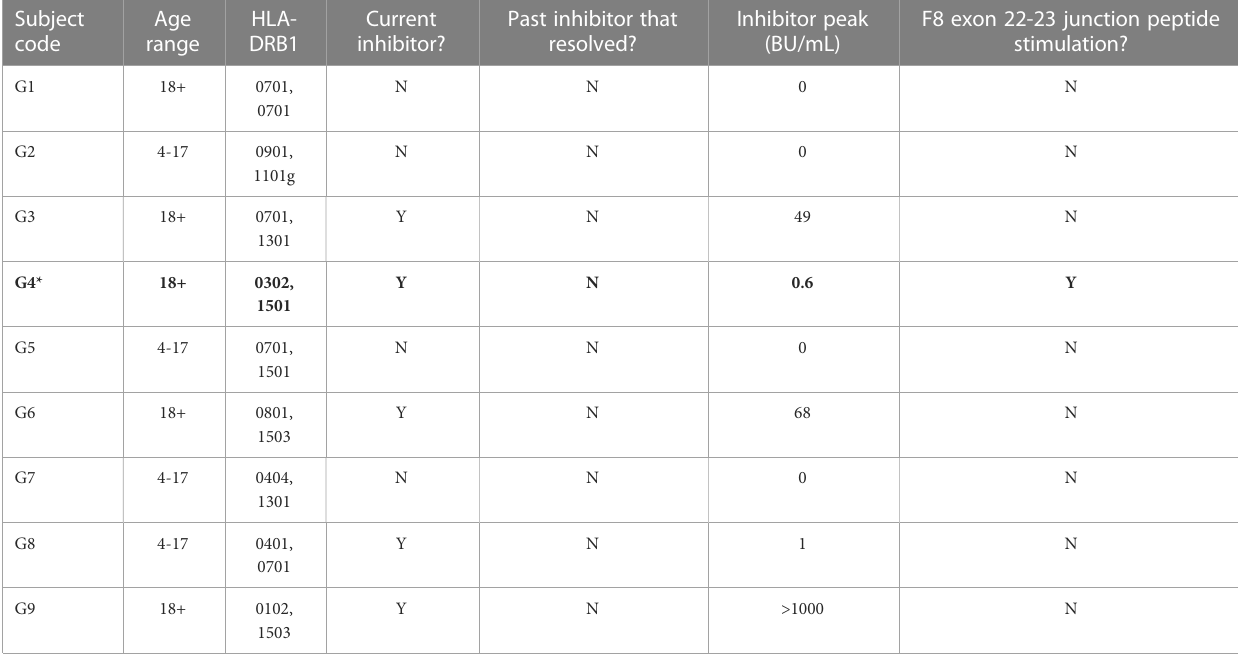
TABLE 3 IFN- g ELiSpot responses of Int22Inv PBMCs to pooled junction peptides (FVIII